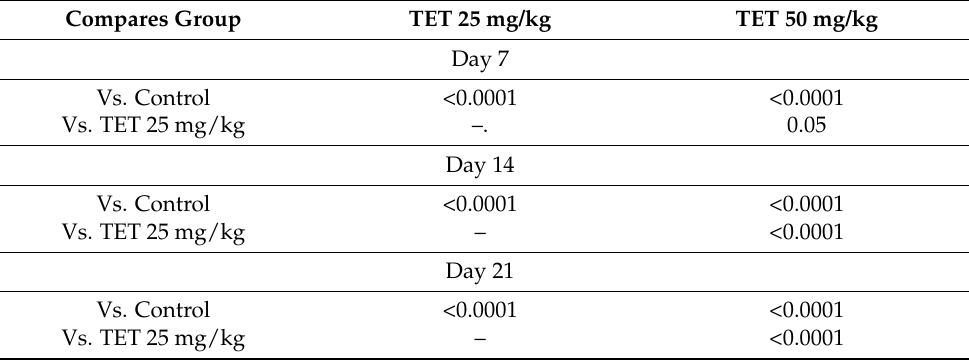
Table 3. The accurate p -value in Figure 4B is displayed. Here we summarized the p -value between control and two treatment groups of Luc2 signal